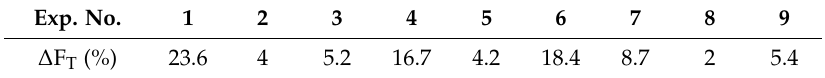
Table 13. Estimation of error of cutting force determined with Gauss-Newton method.